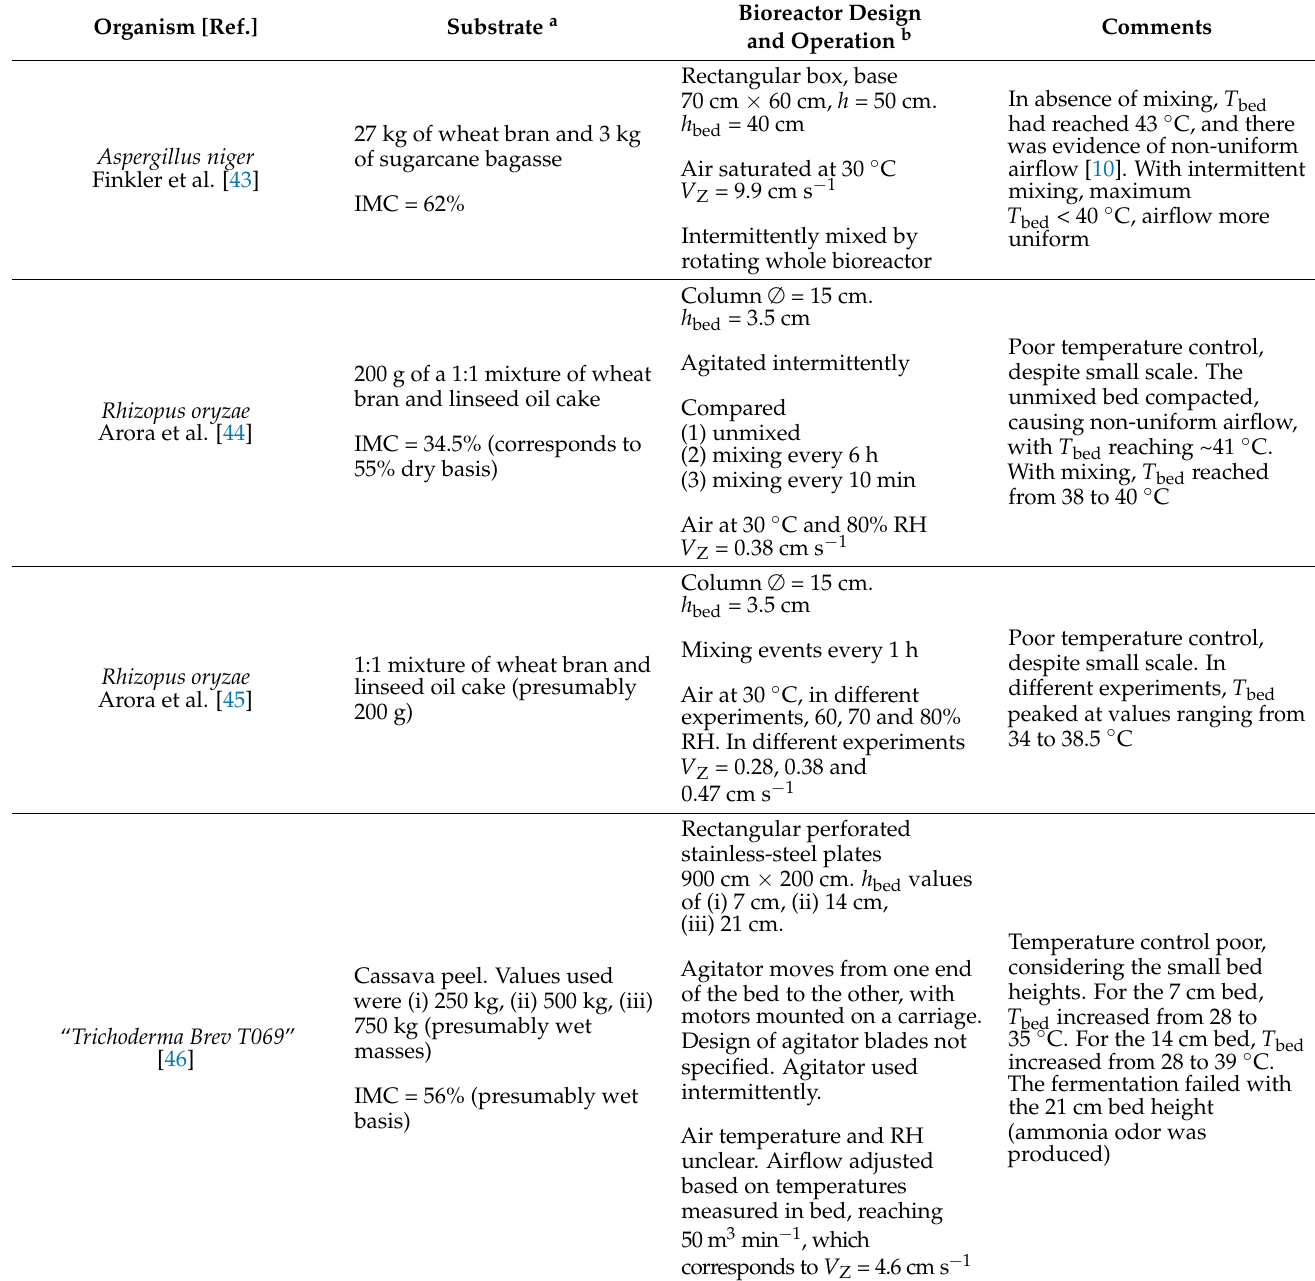
Table 5. Studies of the use of infrequent mixing in packed-bed